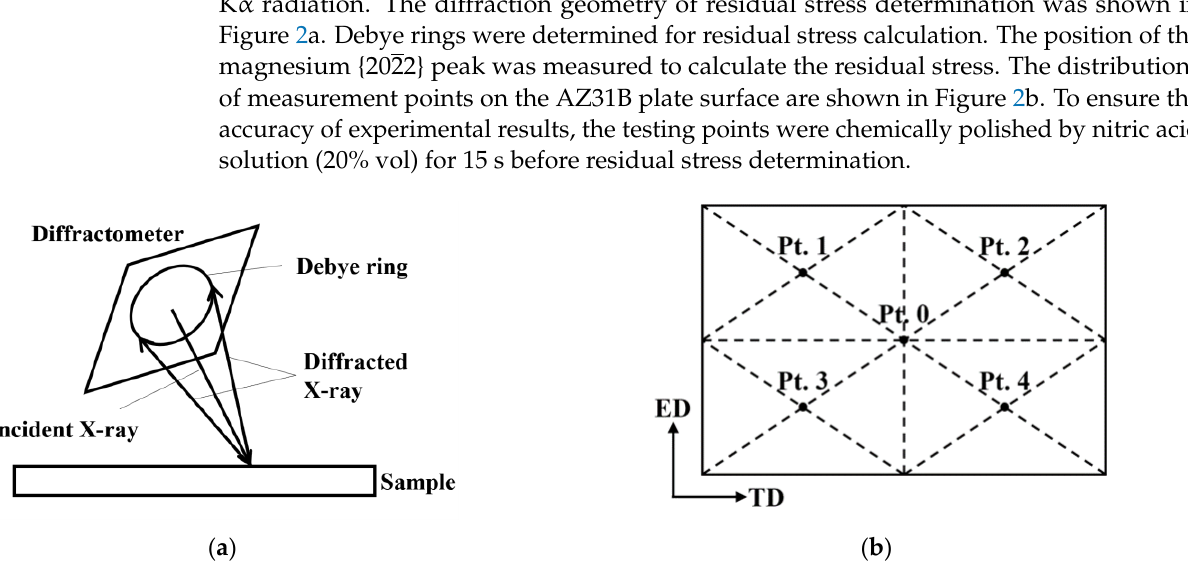
Figure 1. Three uphill quenching processes.